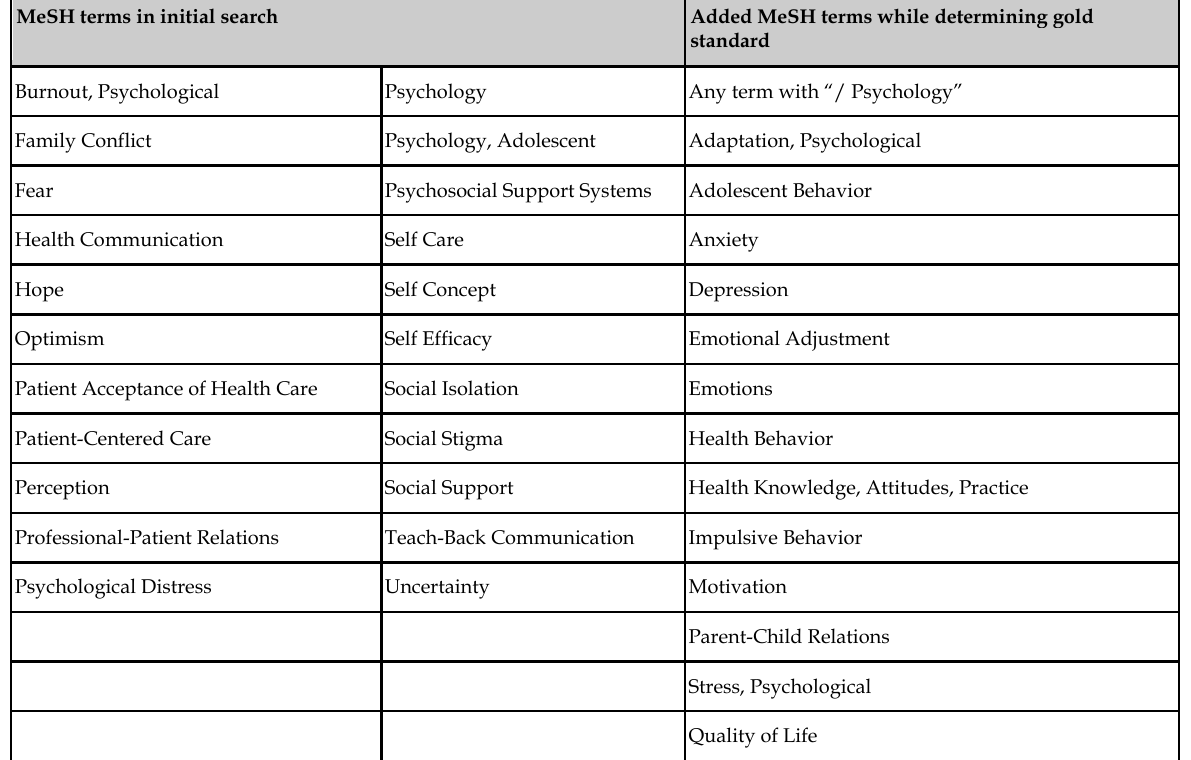
Table 1 MeSH terms used to evaluate source relevance MeSH terms in initial